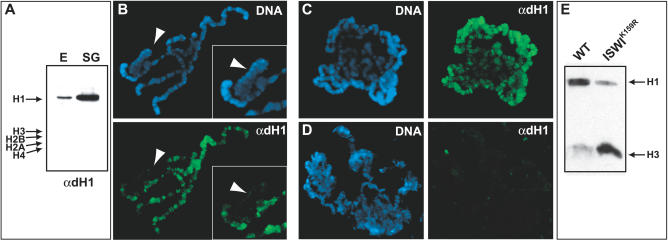
Loss of ISWI Results in Loss of Histone H1(A) A polyclonal antibody (αdH1) specifically recognizes histone H1 in both embryo (E) and salivary gland (SG) extracts by protein blotting.(B) Immunostaining of male Iswi1/Iswi2 polytene chromosomes with antibodies against histone H1 reveals that the levels of histone H1 are dramatically reduced on the decondensed X chromosome (arrowheads). The inserts show an enlarged image of the male X chromosome.(C and D) Wild-type chromosomes exhibit uniform staining with antibodies against histone H1 (C), whereas both the X chromosome and autosomes of larvae expressing ISWIK159R have dramatically reduced staining (D). The images were captured with comparable exposure times.(E) Histone H1 levels are compared to histone H3 levels in salivary gland chromatin extracts by protein blotting using antibodies that specifically recognize Drosophila histone H1 [54] and histone H3 (Abcam, catalog number ab1791). Chromatin from larvae expressing ISWIK159R was intentionally overloaded to ensure visualization of the histone H1 band. Consistent with the results presented in (D), the expression of ISWIK159R leads to a significant (∼5-fold) reduction compared to wild-type (WT) in the ratio of histone H1 to histone H3 associated with chromatin.